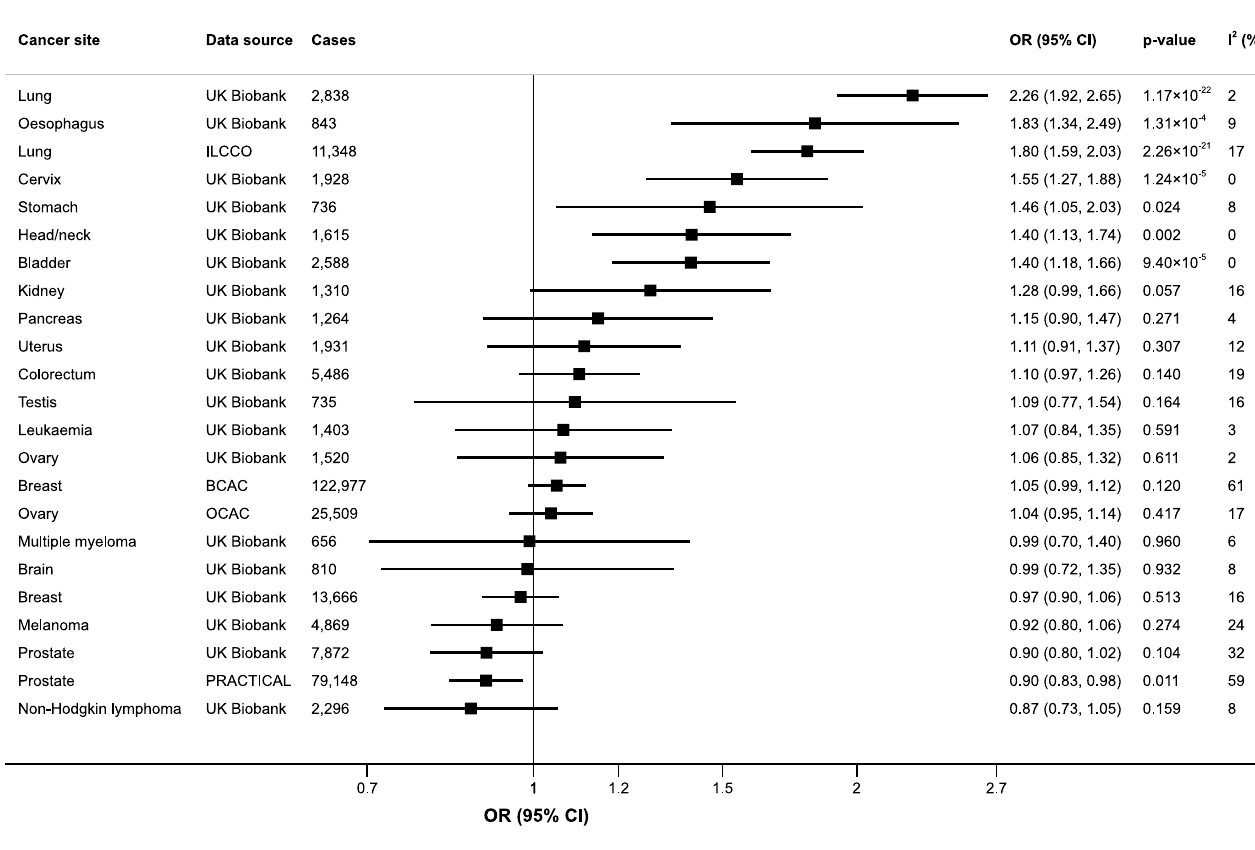
Fig 1. Associations of genetic predisposition to smoking initiation with site-specific cancers. ORs are per one standard deviation increase in probability of smoking initiation (ever smoked regularly). Results are obtained from the random-effects inverse-variance weighted method. The I 2 statistic quantifies the amount of heterogeneity among estimates based on individual SNPs. BCAC, Breast Cancer Association Consortium; CI, confidence interval; ILCCO, International Lung Cancer Consortium; OCAC, Ovarian Cancer Association Consortium; OR, odds ratio; PRACTICAL, Prostate Cancer Association Group to Investigate Cancer Associated Alterations in the Genome consortium; SNP, single-nucleotide